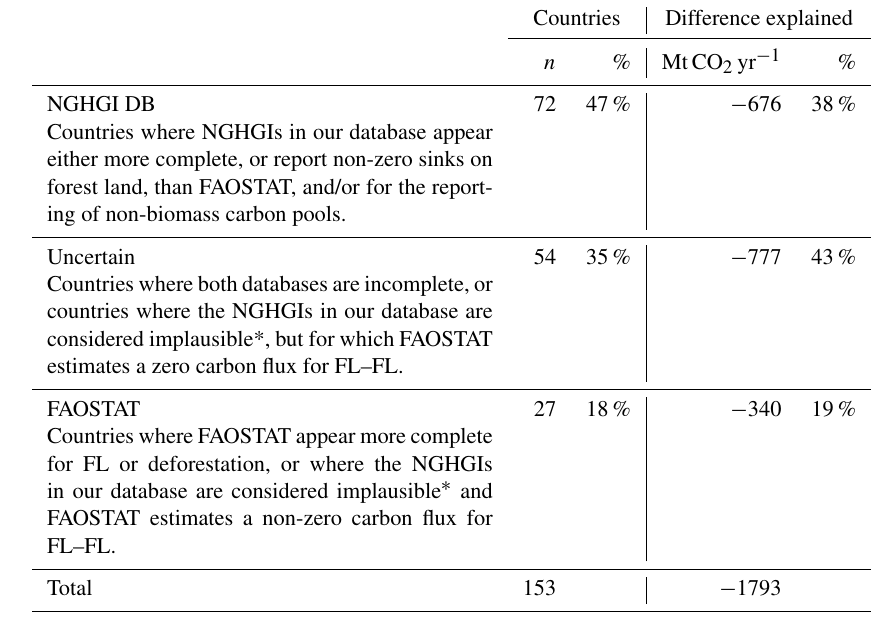
Table 9. Assessment of the reasons for the difference between the NGHGI database and FAOSTAT for 153 NAI countries, based on the completeness/uncertainty in the estimates of forest land (FL) and deforestation, and of carbon pools included. The method used is illustrated in Fig. S2. The total flux ( − 1793MtCO 2 yr − 1 ) is the average difference, for the sum of FL and deforestation in NAI countries,